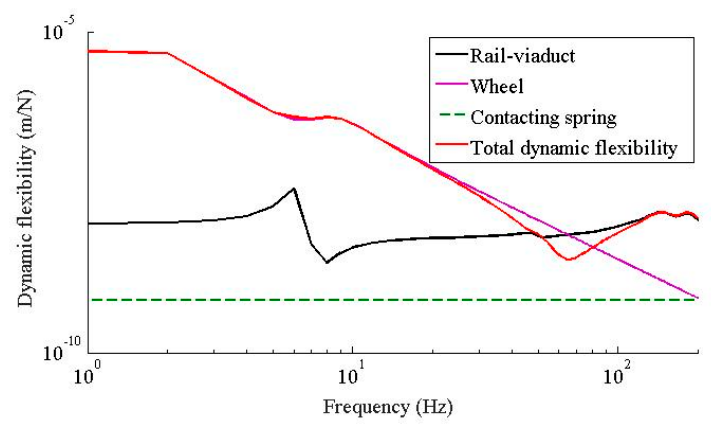
Figure 18. Dynamic flexibility of the vehicle-rail-viaduct system.